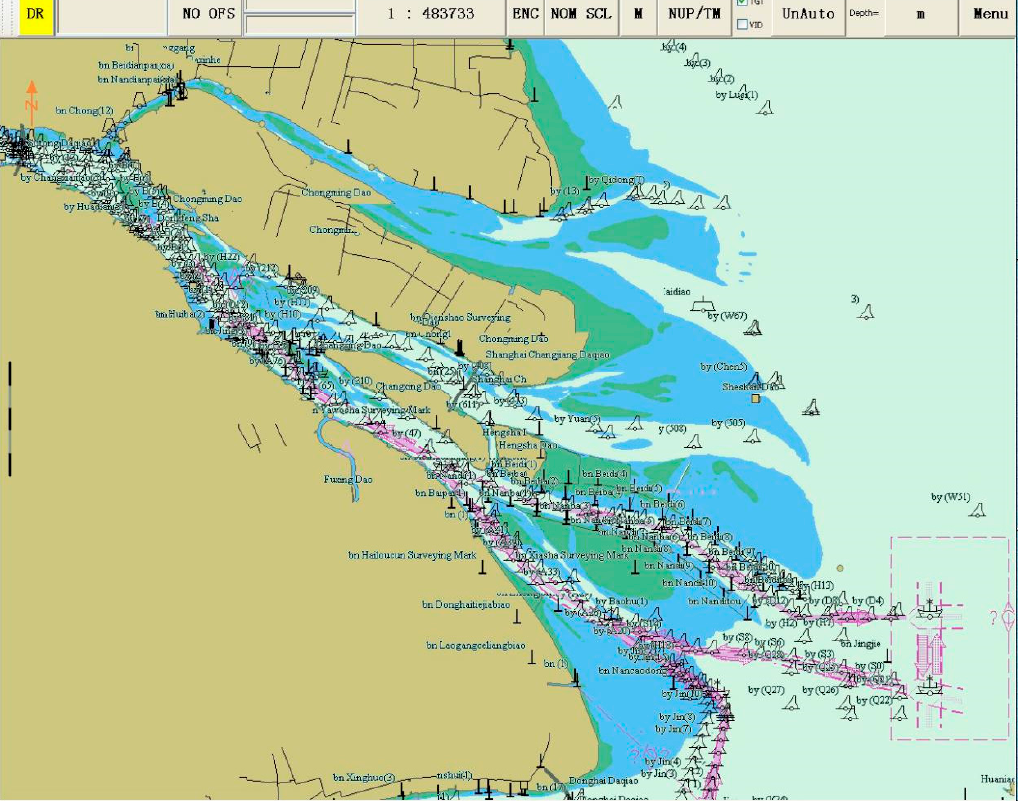
Figure 4. The Yangtze River estuary (This figure was produced by HTA-ES5000 Electronic Chart Simulator (ED001, Dalian, CHINA).